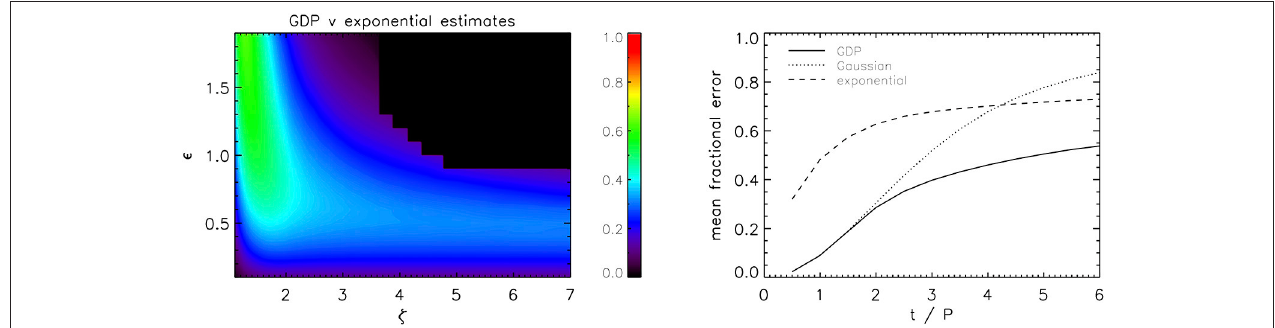
FIGURE 7 | Difference between the fractional error using the exponential damping profile alone compared with the GDP (left) , and the mean fractional error as a function of time for each of the three TB profiles (right)